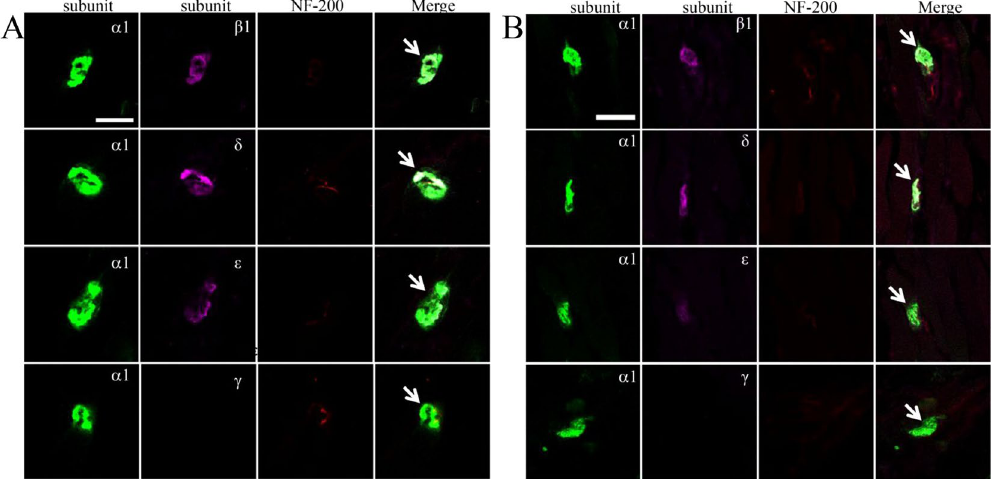
Figure 5. Confocal micrographs showing localization of the α 1, β 1, δ , ε , and γ subunits at the neuromuscular junctions (NMJs) of the ( A ) gastrocnemius and ( B ) normal orbicularis oris. Immunofluorescence staining with α -bungarotoxin (green, mark α 1 subunit), β 1 or δ or ε or γ subunits (pink), and neurofilament 200 (red, mark nerve). Arrows mark the NMJs. Scale bars = 30 μ m.